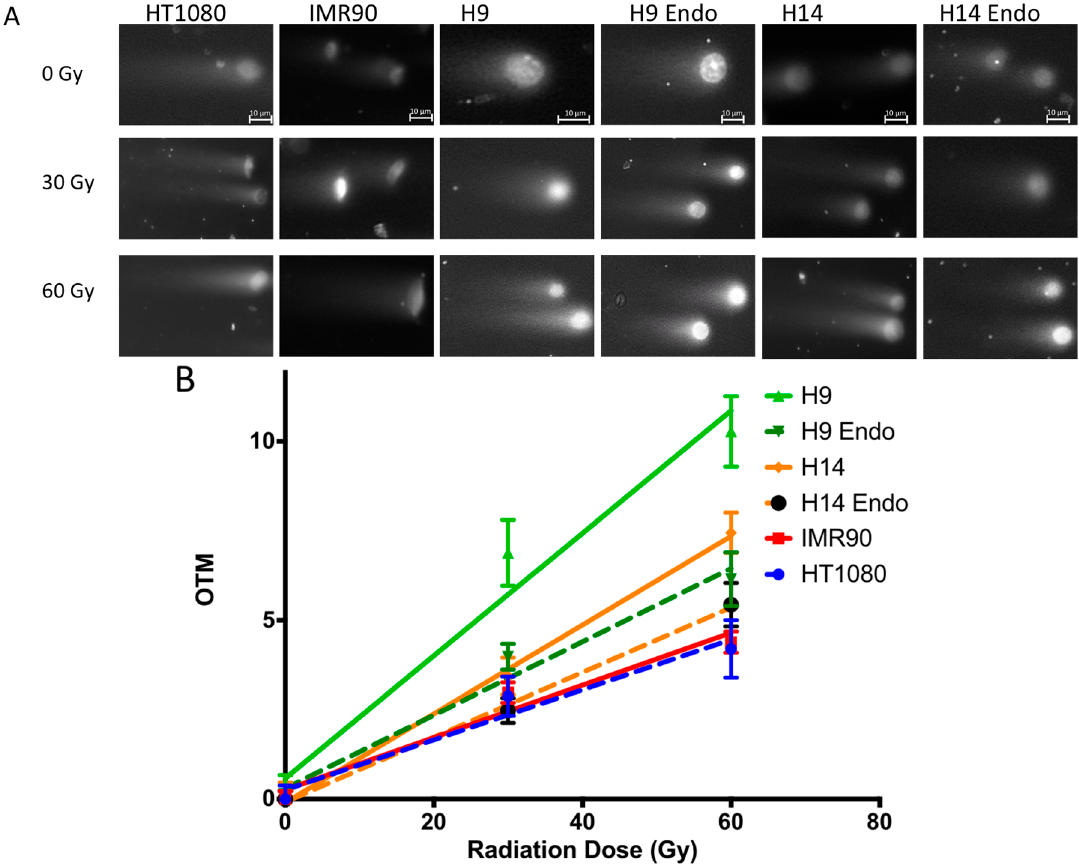
Figure 4. Neutral comet assay. ( A ) Examples of comets after 60 Gy IR; ( B ) Dependence of comet’s olive tail moments (OTM) from IR dose after background subtraction (normalized to 0 OTM at 0 Gy). N > 50 comets for each dose point and cell type were analyzed as described in the Methods. The background OTM at 0 Gy was subtracted from 30 and 60 Gy measurements. Error bars represent standard errors of the mean (SEM). Data points were fitted with linear regression lines; R 2 value for all curves was significant (>95%). OTM of H9 hESC was significantly higher than that of H9 endoderm differentiated cells ( p < 0.01), HT1080 fibrosarcoma cells ( p < 0.01), and IMR90 primary fibroblasts ( p < 0.01). The OTM of H14 hESC was higher than that of H14 endoderm differentiated cells ( p = 0.23), and significantly higher than the OTM of HT1080 cells ( p < 0.01) and IMR90 cells ( p < 0.01).